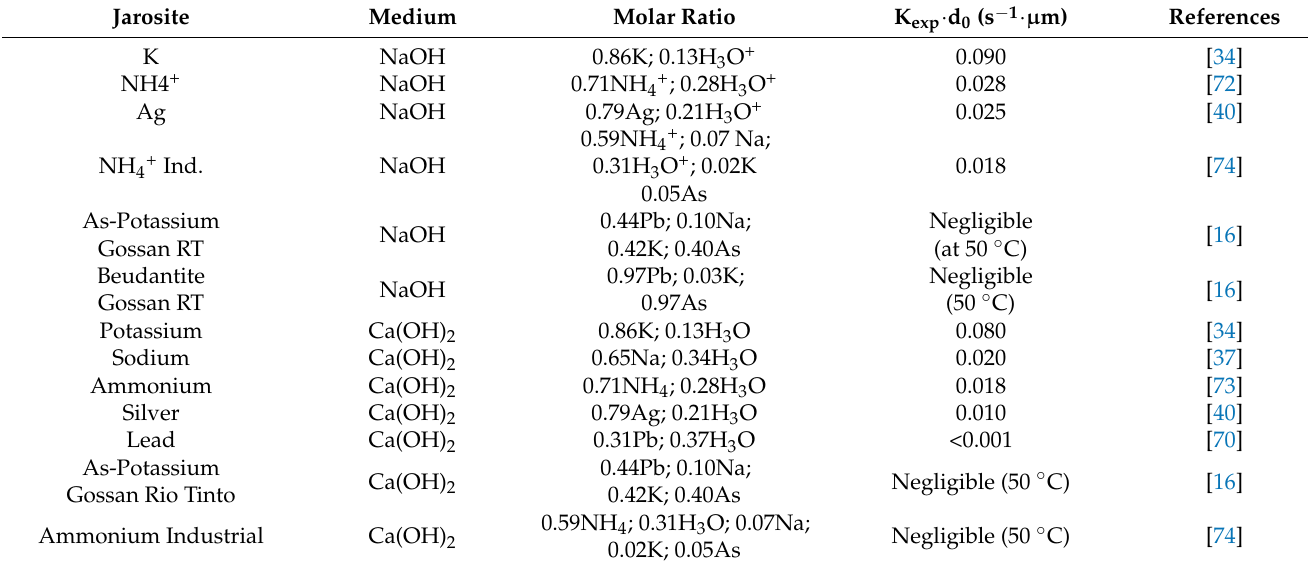
Table 6. Cyanidation rate of jarosites in NaOH and Ca(OH) 2 media [72,73].